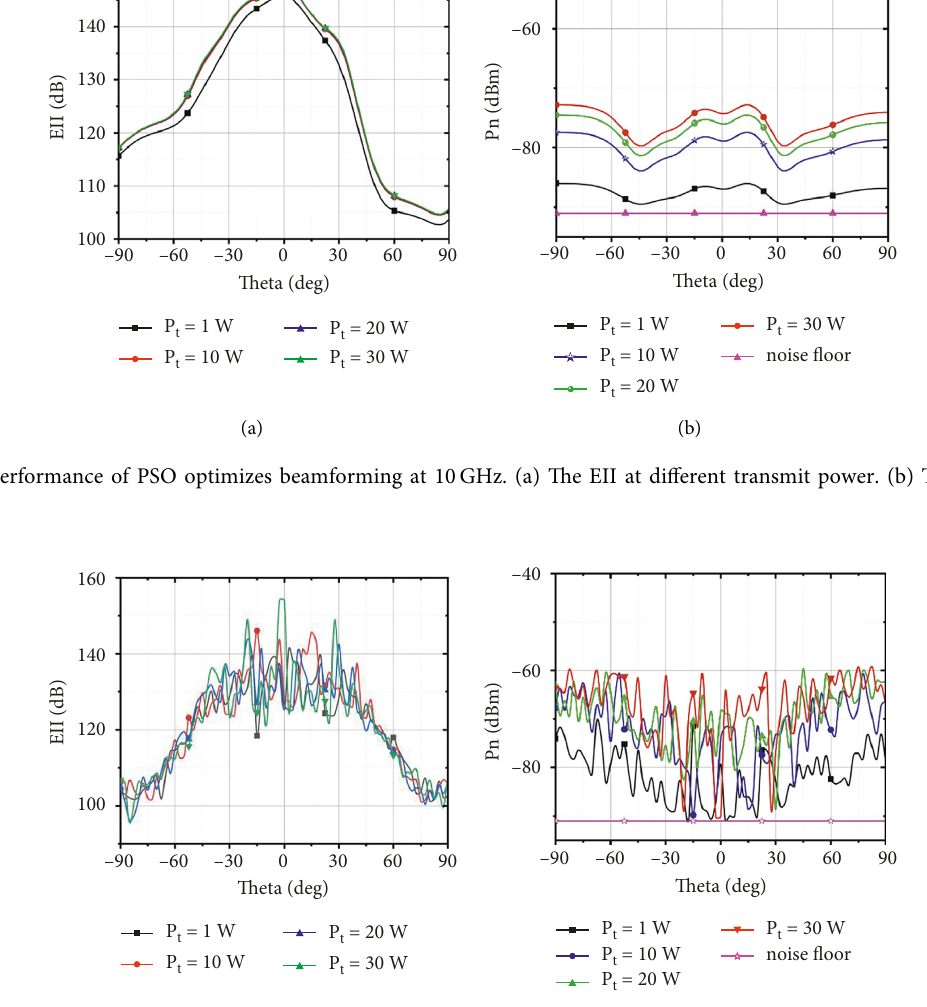
Figure 7: The performance of GA-PSO optimizes array partitioning and beamforming at 10GHz. (a) The EII at different transmit power. (b) The P n at different transmit power.